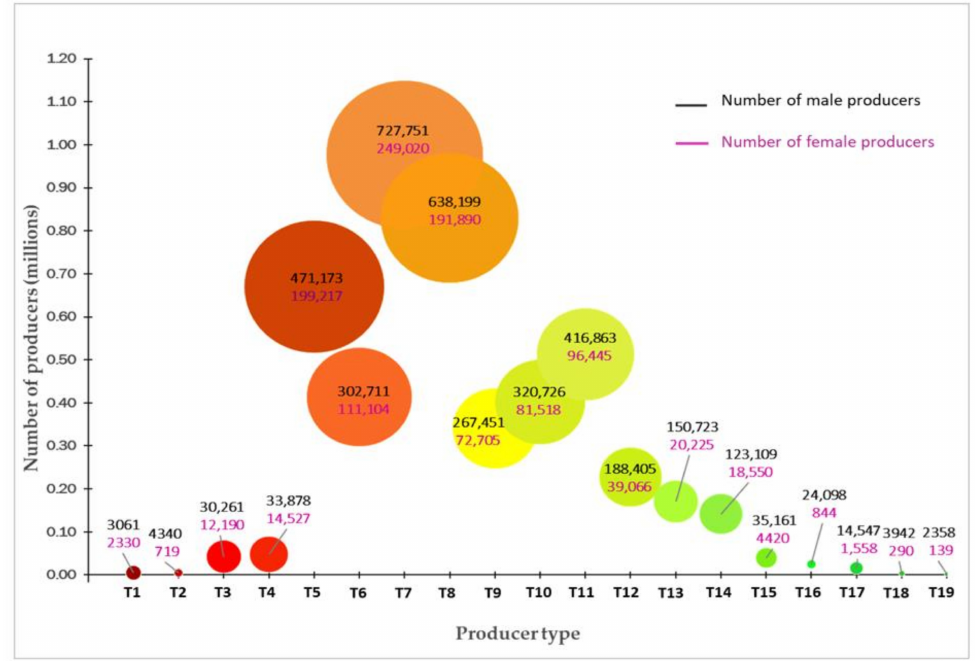
Figure 2. Producer types (T) and total producers in each